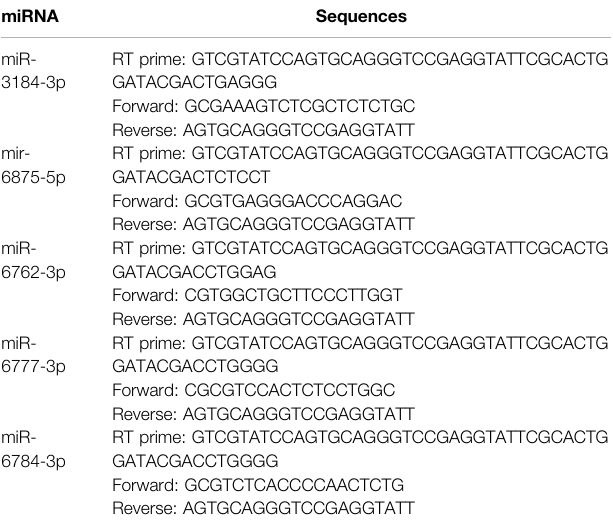
TABLE 1 | List of primers used for qRT-PCR.